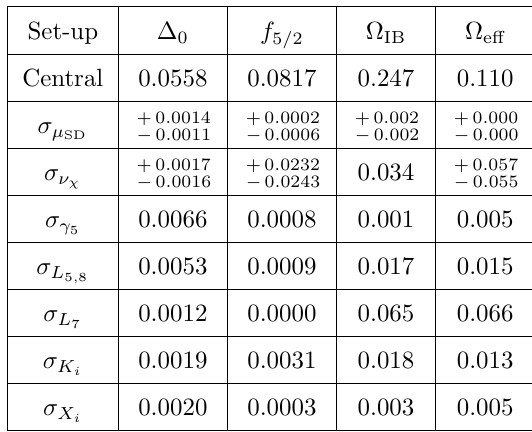
Table 15 . NLO central values for (cid:11) 6 = 0 and their parametric